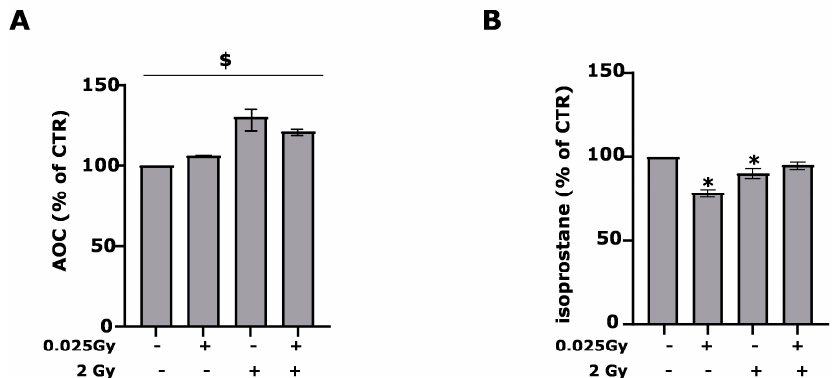
Figure 2. Priming dose effect on oxidative stress parameters. After 24 h post-irradiation, the release of AOC in ( A ) ($ p < 0.001 compared to average baseline and each treatment, Wilcoxon signed-rank test) and of isoprostane in ( B ) (* p < 0.05 vs. CTR, unpaired two-tailed Student’s t -test) in the retinal cell culture medium were evaluated. Data are expressed as % of CTR and mean ± SEM of 3 to 5 independent experiments.